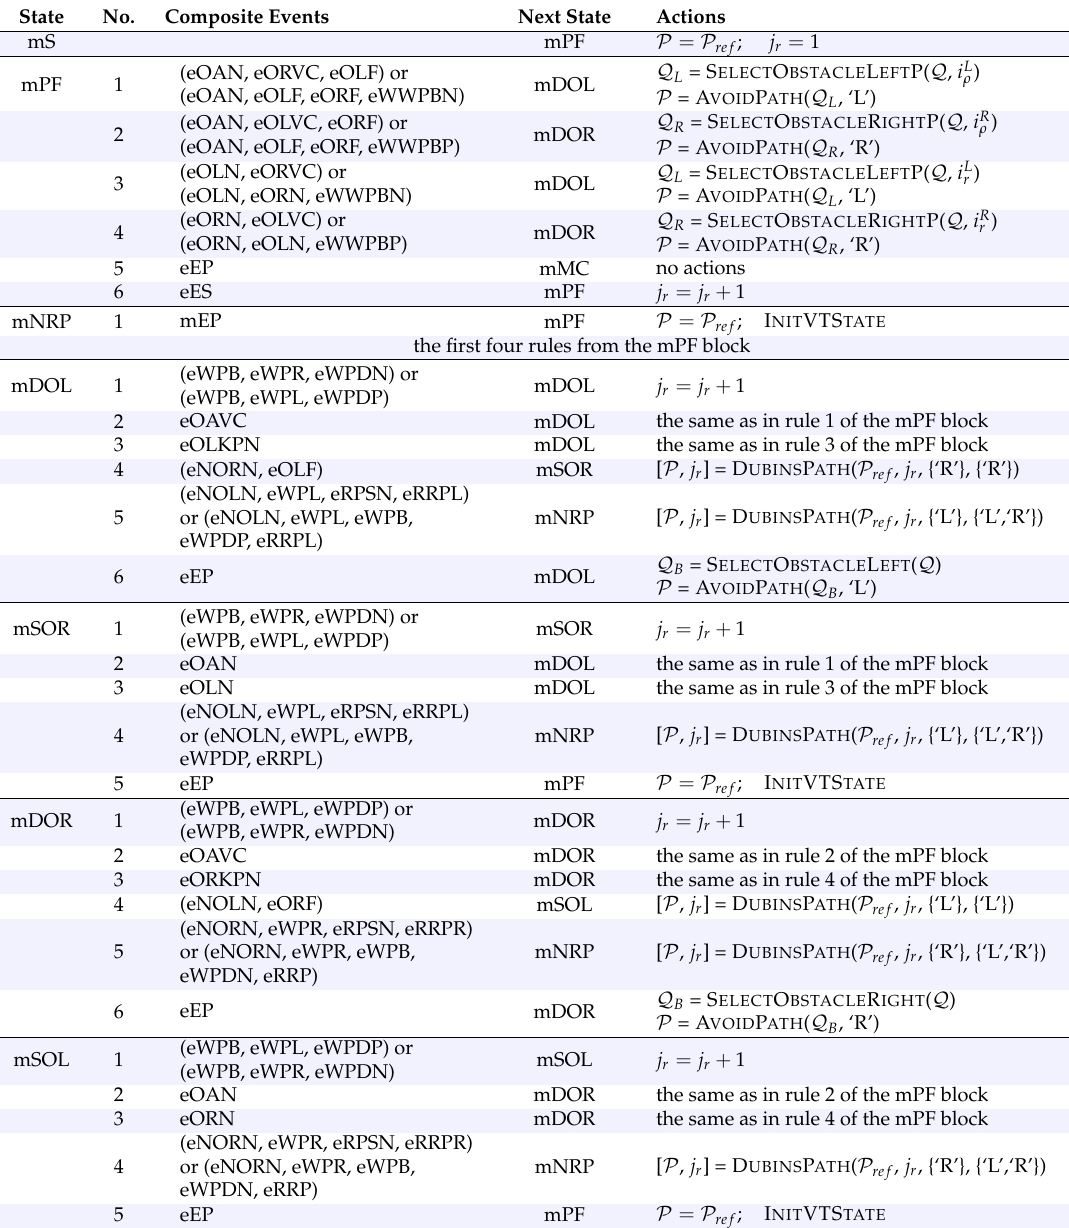
Table 3. Transition rules of the